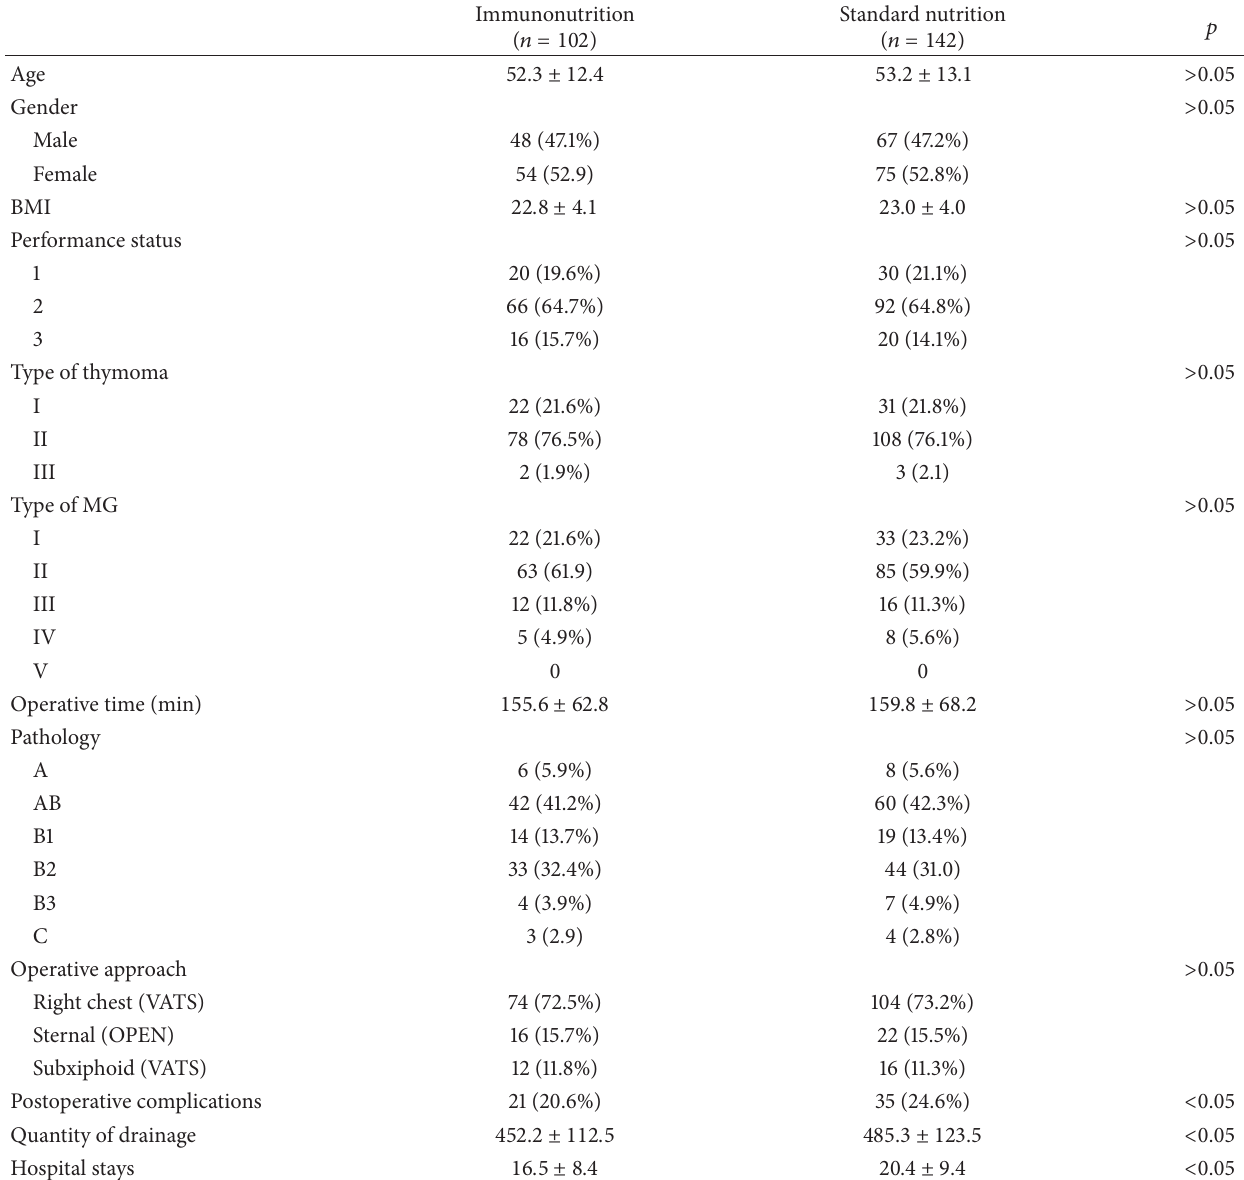
Table 2: Patient characteristics between two